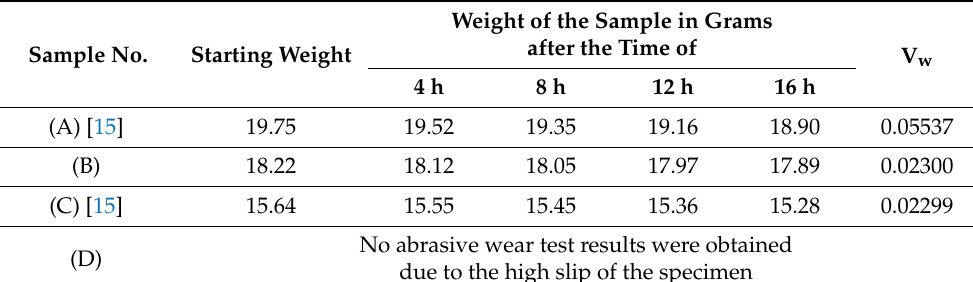
Table 4. The results of the abrasion wear test.